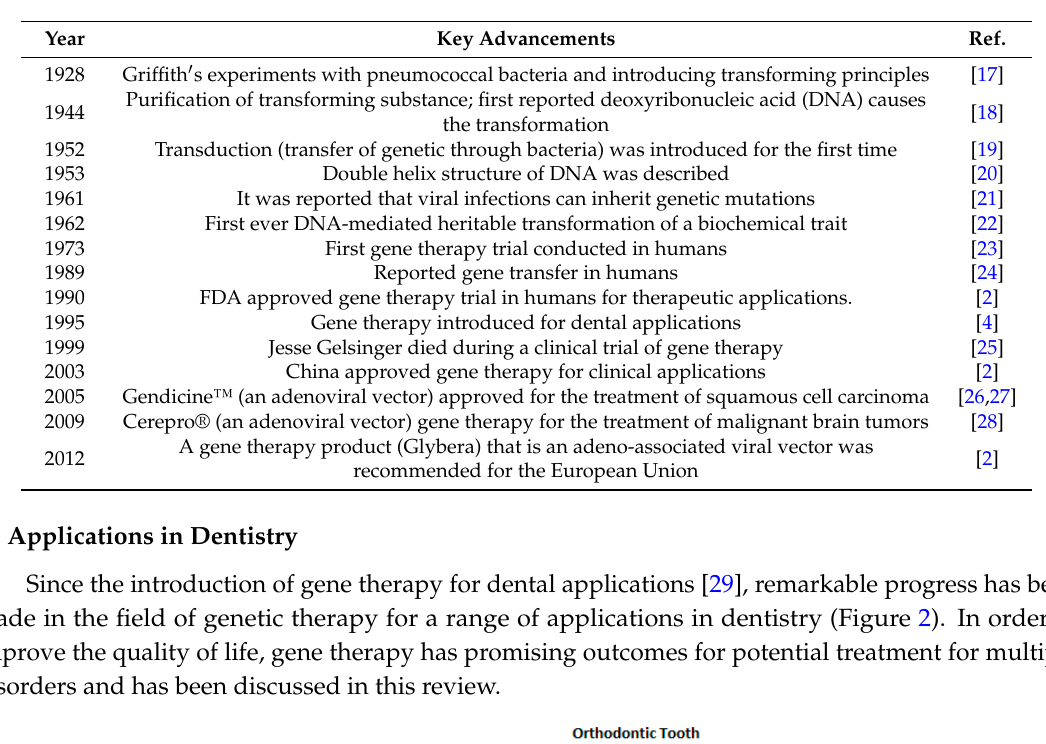
Table 1. Chronological advancements in gene therapy approaches.